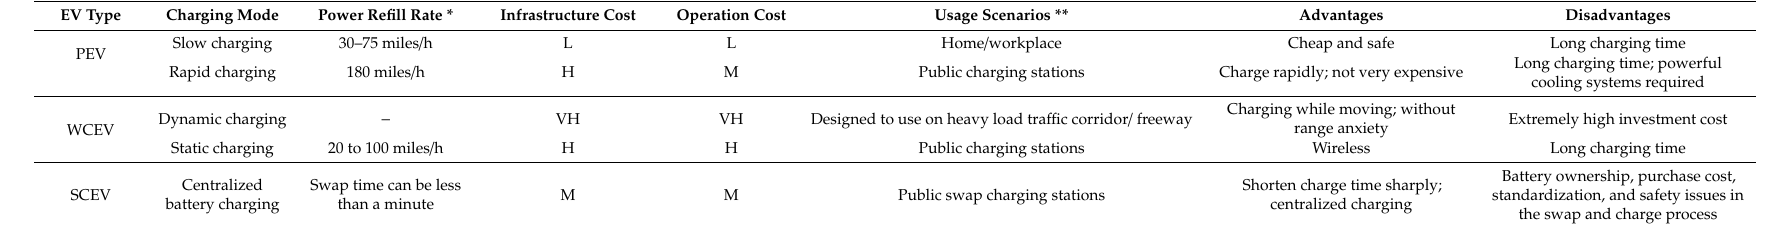
Table 1. EV charging infrastructure